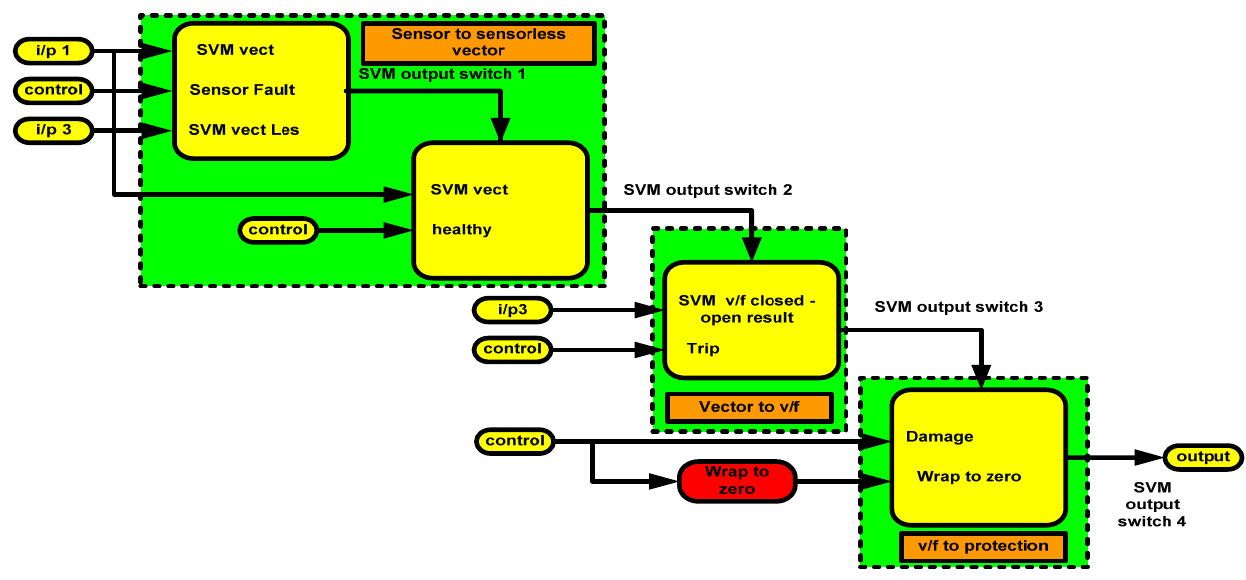
Figure 9. Switching mechanism between the